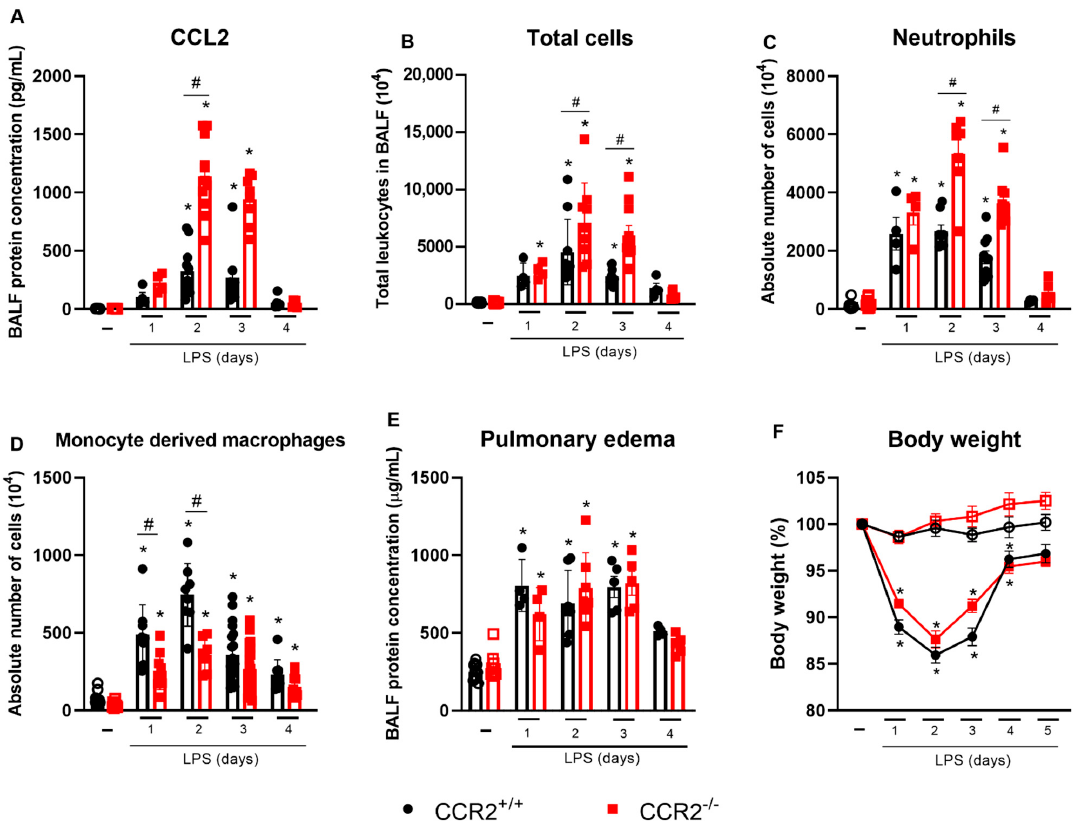
Figure 1. CCR2 absence results in increased accumulation of neutrophils and decreased macrophage numbers in the lungs without affecting changes in inflammation, pulmonary edema, or weight loss. CCR2 +/+ (black symbols) and CCR2 − / − (red symbols) C57BL/6 mice were challenged with LPS (12.5 µg/mouse) or PBS (ctrl group; -) and dissected at the indicated days. Levels of CCL2 ( A ) were measured in the BALF by ELISA. Absolute numbers of leukocytes in BALF ( B ) were counted in Bürker chamber. Absolute numbers of neutrophils (CD45 + Ly6G + CD11b + ) ( C ) or macrophages (CD45 + CD11b + Ly6G − CD3 − CD19 − NKp46 − CD103 − SiglecF − CD11c − cells) ( D ) isolated from the lungs and BALF were quantified by flow cytometry. Pulmonary edema was quantified based on the protein concentration in the BALF ( E ). Changes in body weight ( F ) were calculated with the weight before challenge (day 0) as reference. Compilation of three experiments. Data are shown as mean ± SEM. Each symbol in panels A to E represents data of an individual mouse. * p < 0.05 when compared with the healthy, unchallenged control group. # p < 0.05 when comparing wild type and knockout group at the same time point. ANOVA test followed by Bonferroni correction was used in panel F; Kruskal–Wallis with Dunn’s multiple comparisons test was used in panels A–E. n = 6–12.